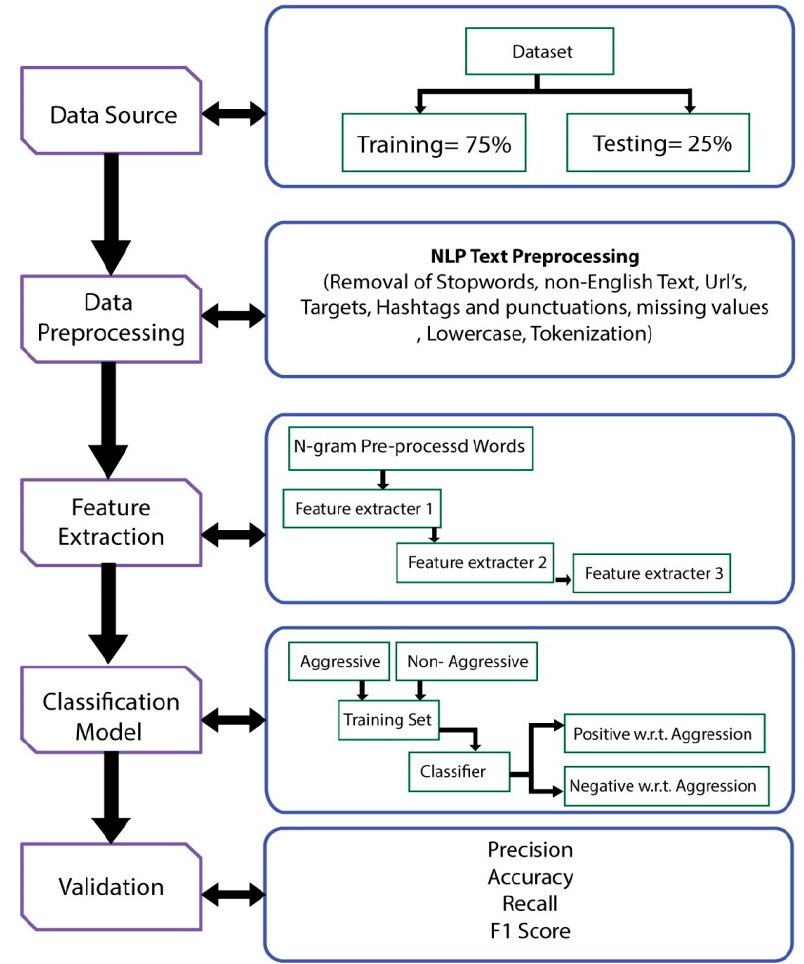
Figure 5. Proposed Methodology for Behavior Detection.